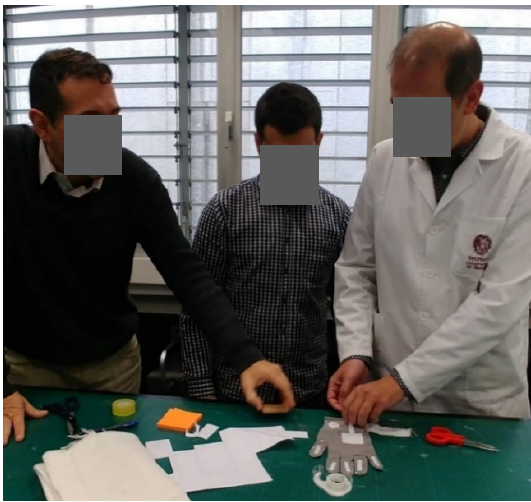
Figure 13. Internal Workshop participants during the Low-Fidelity Prototype Development.